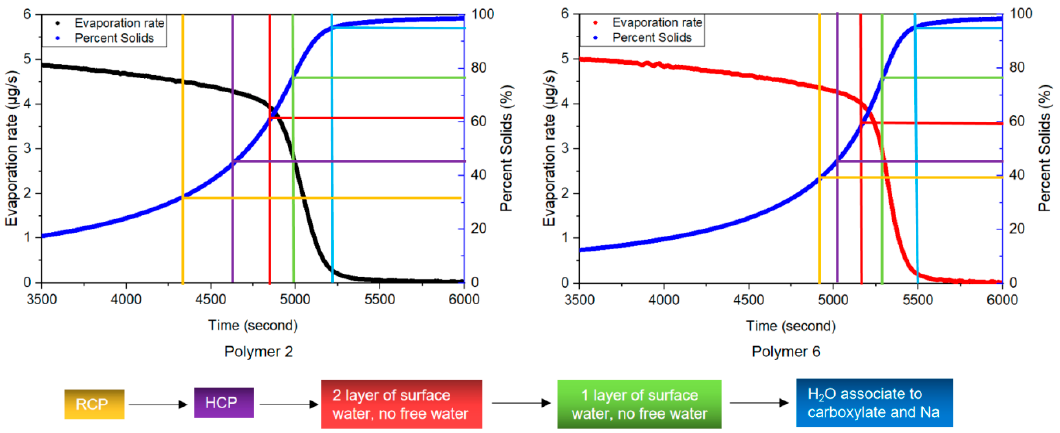
Figure 12. Evaporation rate of water at different percent solids, 5.04% Polymer 2, 4.35% Polymer